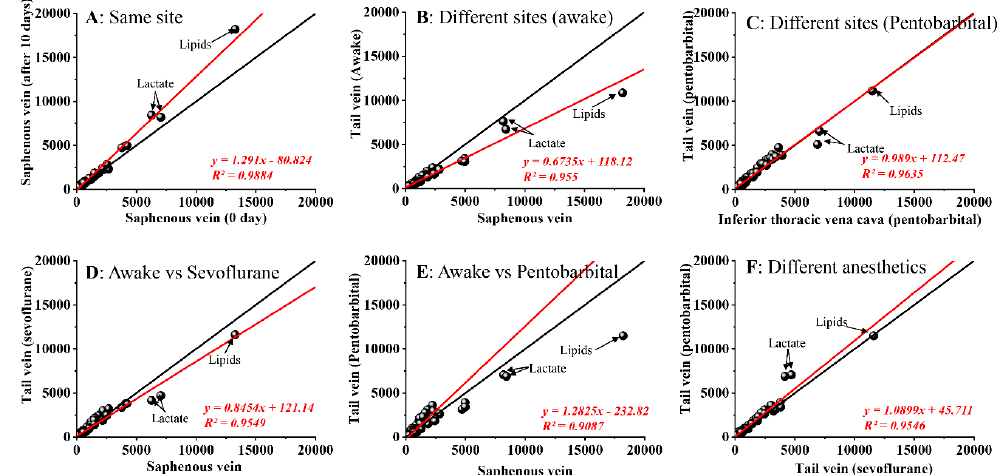
Figure 4. Correlations of different kinds of blood samples, including same site under different periods ( A ), different sites under various brain states ( B and C ), and different kinds of anesthetized states ( D , E and F ).